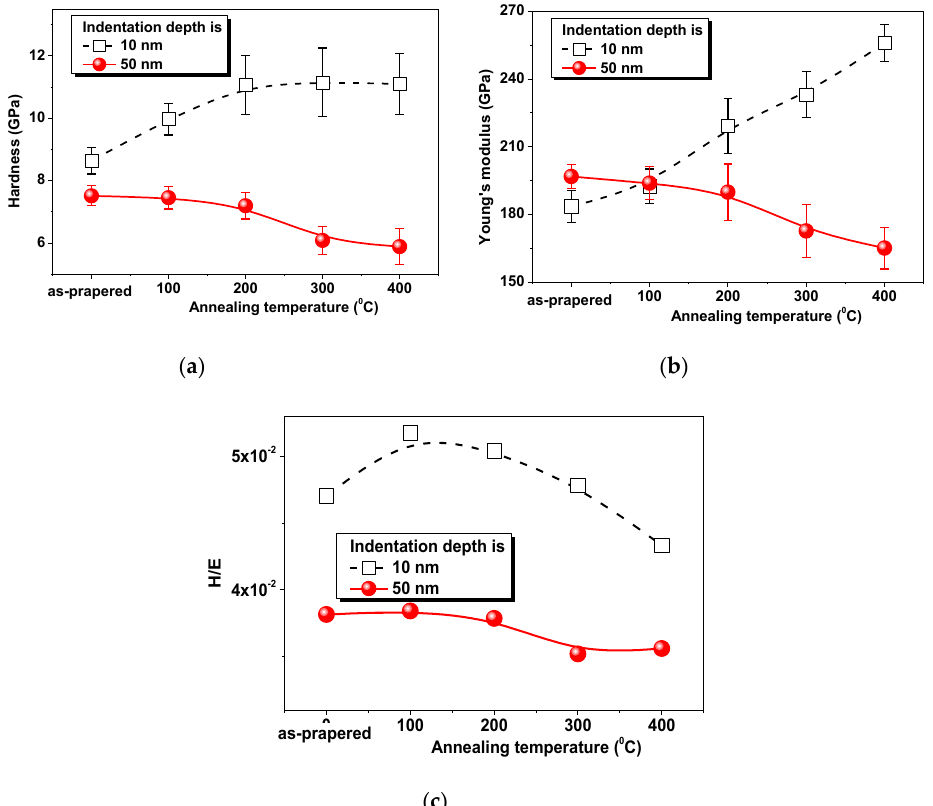
Figure 3. Mechanical properties of the Au/NiFe nanostructured system with indentation depth of 10 nm (black squares) and 50 nm (red circles) after heat treatment investigated using nanoindentation. ( a ) Dependence of the hardness, ( b ) Young’s modulus, and ( c ) resistance to the elastoplastic deformation on the heat treatment temperature.